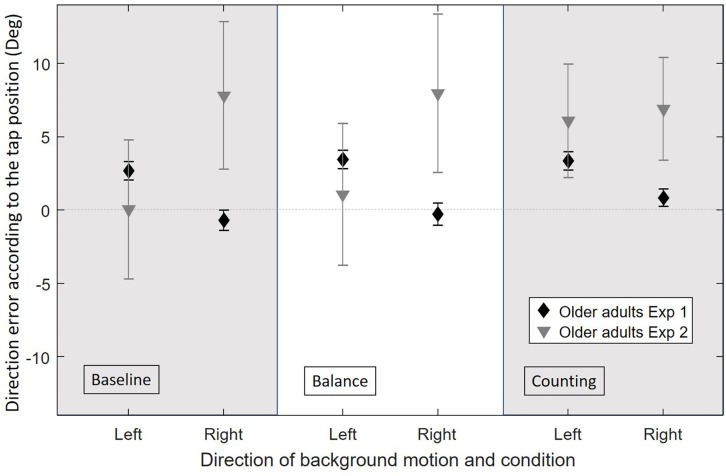
Average direction error in degrees for OA in the original experiment (Exp1, n = 19) and in the current experiment [Exp2, (baseline: n = 22, balance: n = 19, counting: n = 16)], for each experimental condition (baseline, balance, and counting) and for each background direction of motion (left or right) merged between the different directions of the target’s motion (horizontal velocities: −7.2, 0, and 7.2 cm/s). Error bars represent the standard error of the mean between subjects.